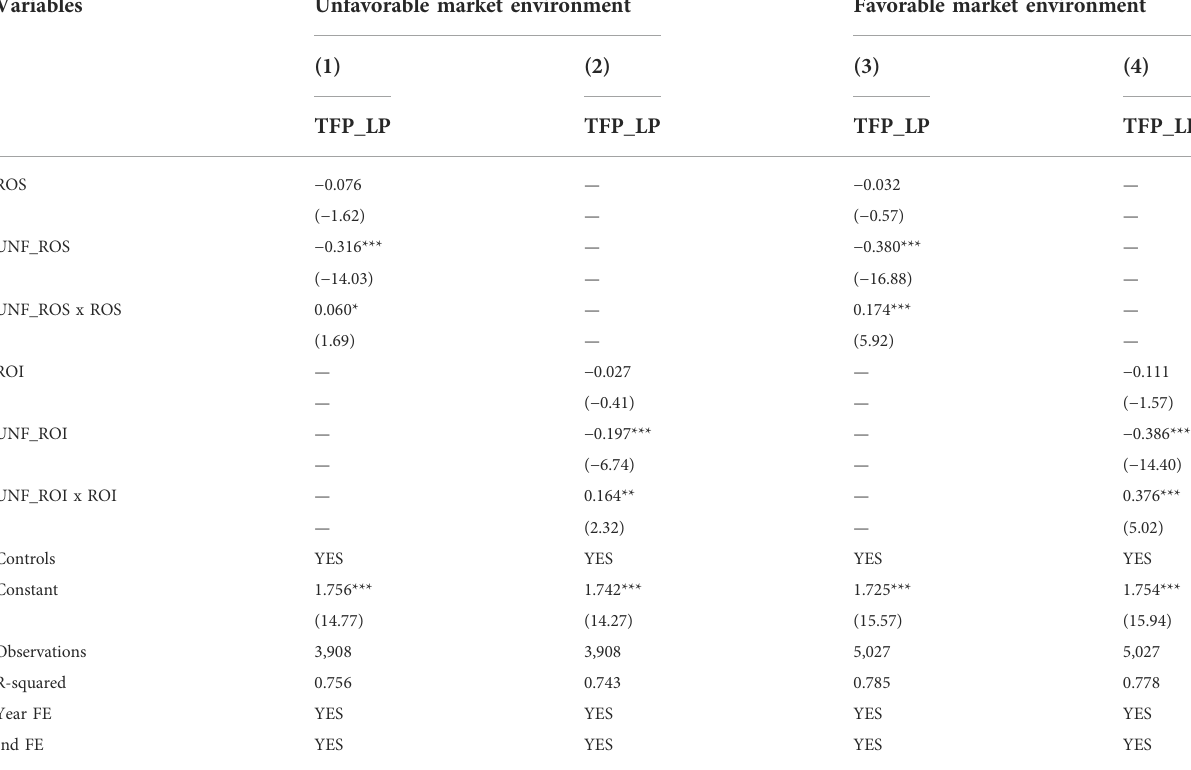
TABLE 14 Heterogeneity tests for different market